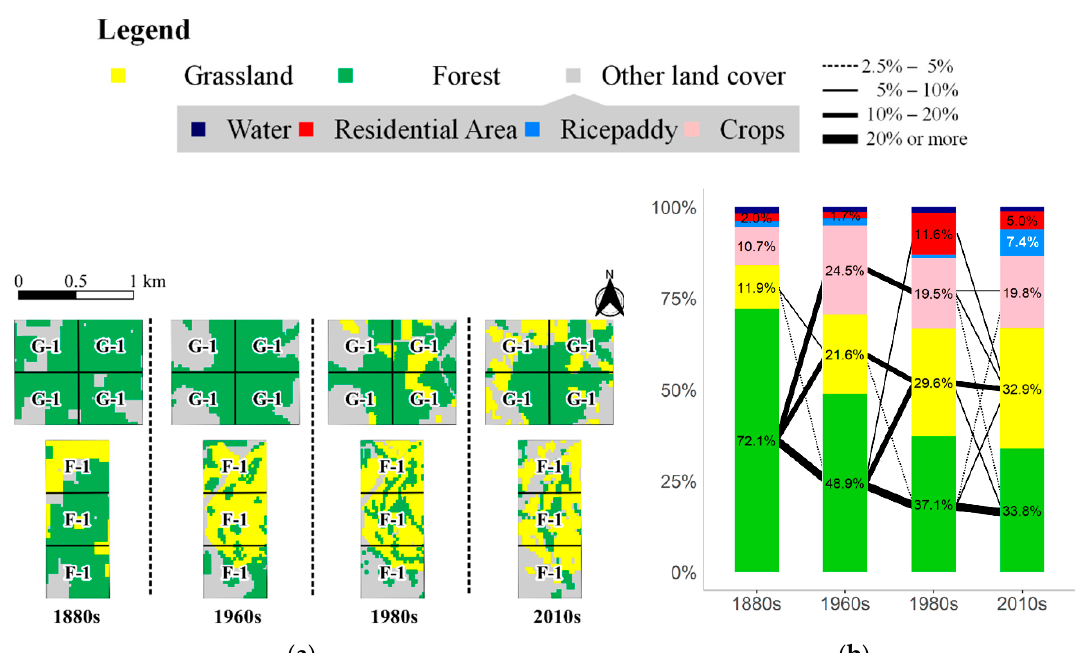
natural environments (Forest and Grassland). ( b ) shows the changes in land cover types between the 1880s and 2010s. The value in each bar represents the percentage (%) of each land cover type. The connecting line between two bars indicates the change in land cover type through the periods. The thickness of the line corresponds to the proportion of the changed area with respect to the grids shown in ( a ). The line was omitted if the proportion is less than 2.5%.